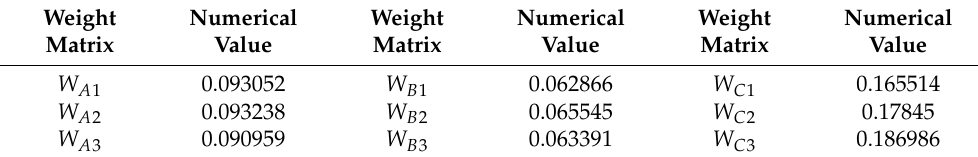
Table 6. Value of total weight matrix for multi − objective evaluation.